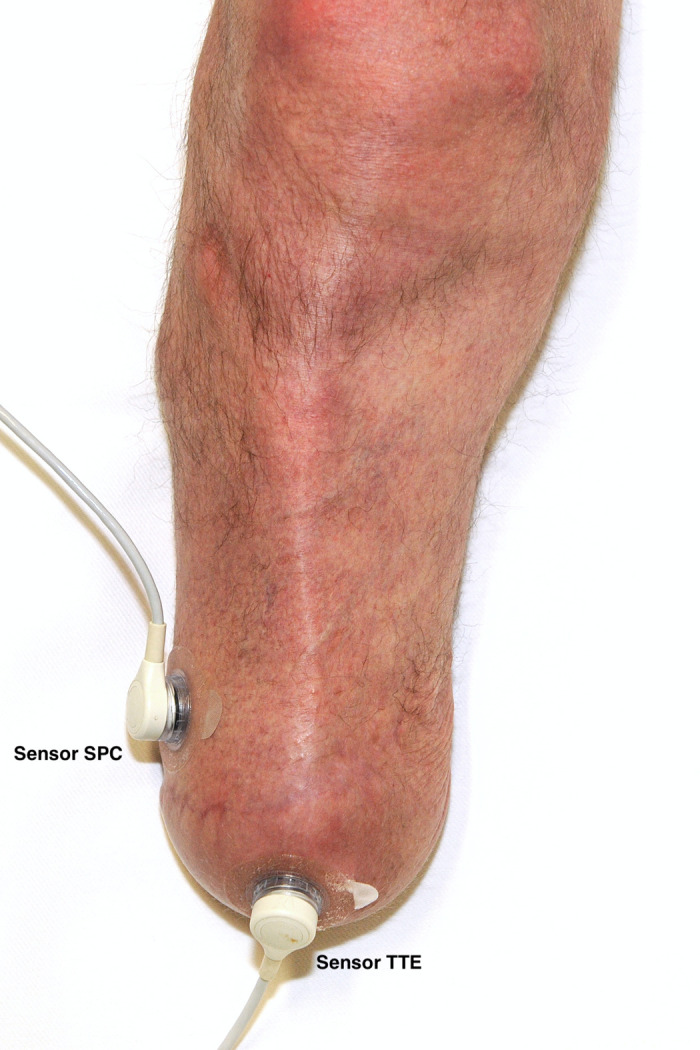
Test setup, anterior view.Sensor TTE placed over the top of the tibia at the most distal part of the posterior Burgess flap, Sensor SPC placed over the peroneal compartment at the most distal part of the anterior Burgess flap.